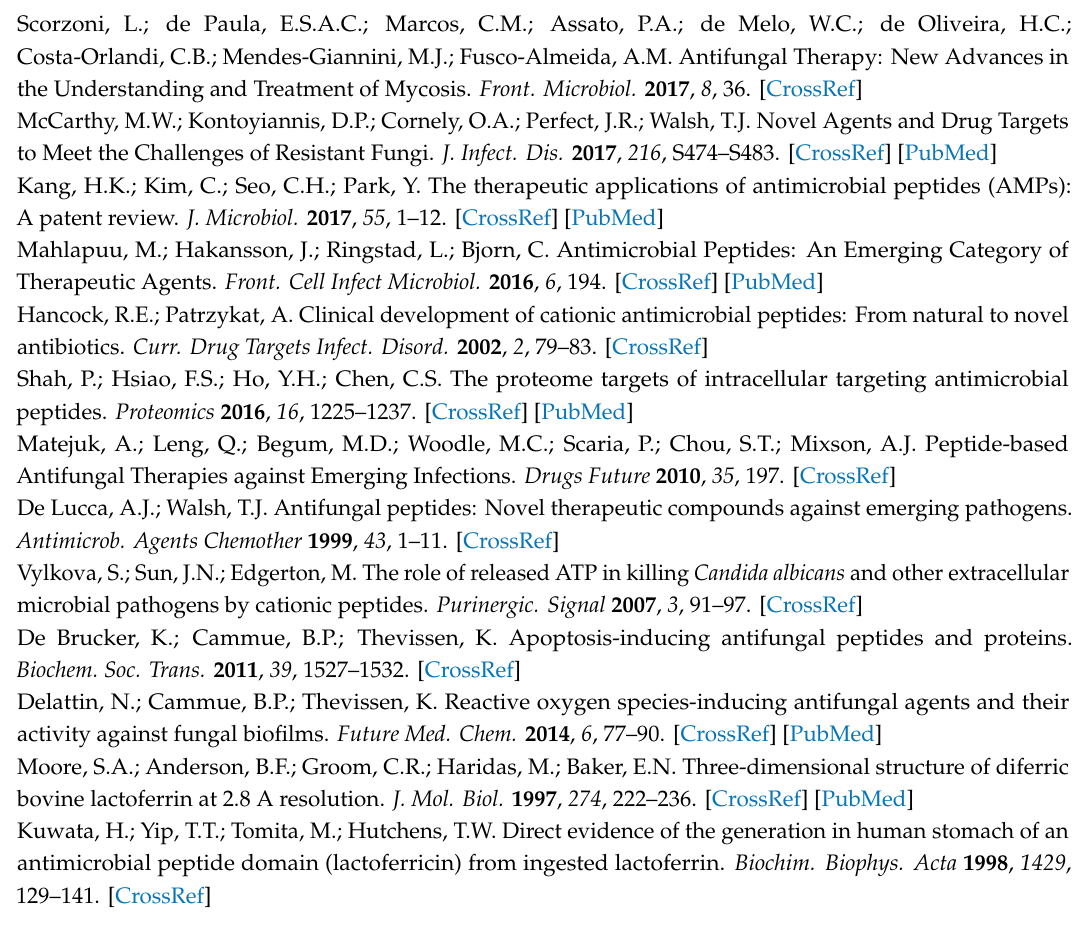
Figure S1: Image of hits belonging to Ergosterol biosynthesis; Lfcin B (ERG7 & ERG1) and Histatin-5 (ERG 12 & ERG1). Table S1: Two standard deviation (2SD) hits of Lfcin B and Histatin-5 from yeast proteome